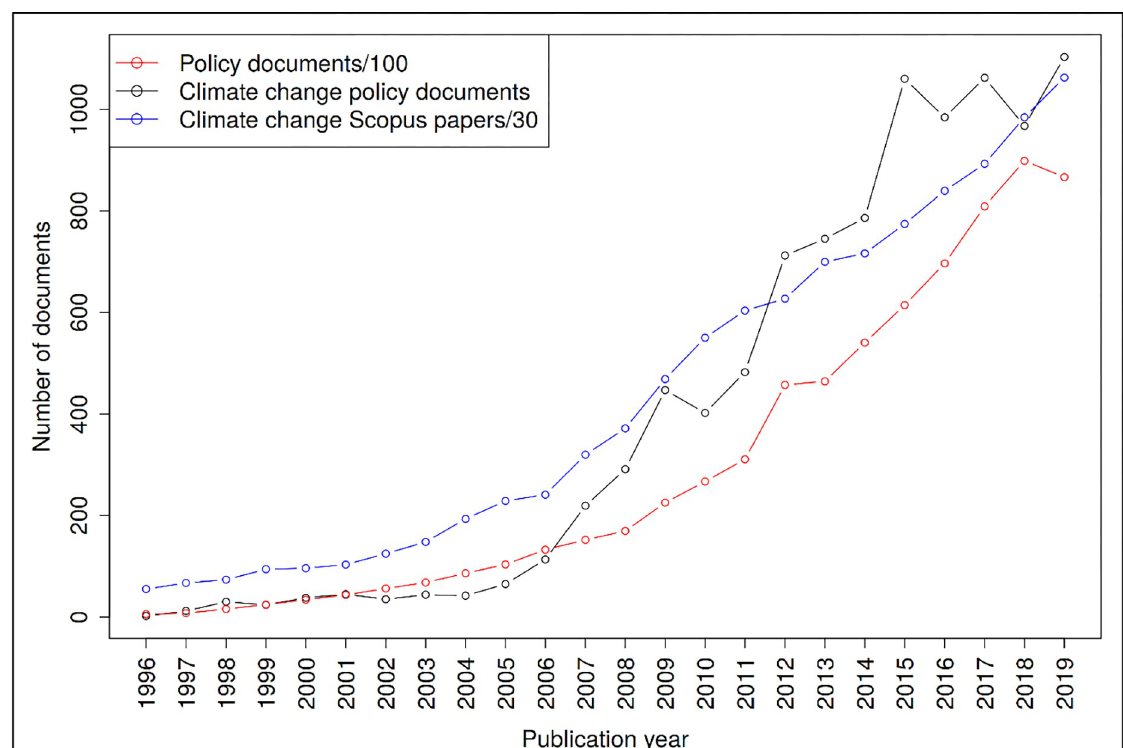
Fig 1. Annual number of policy documents and climate change policy